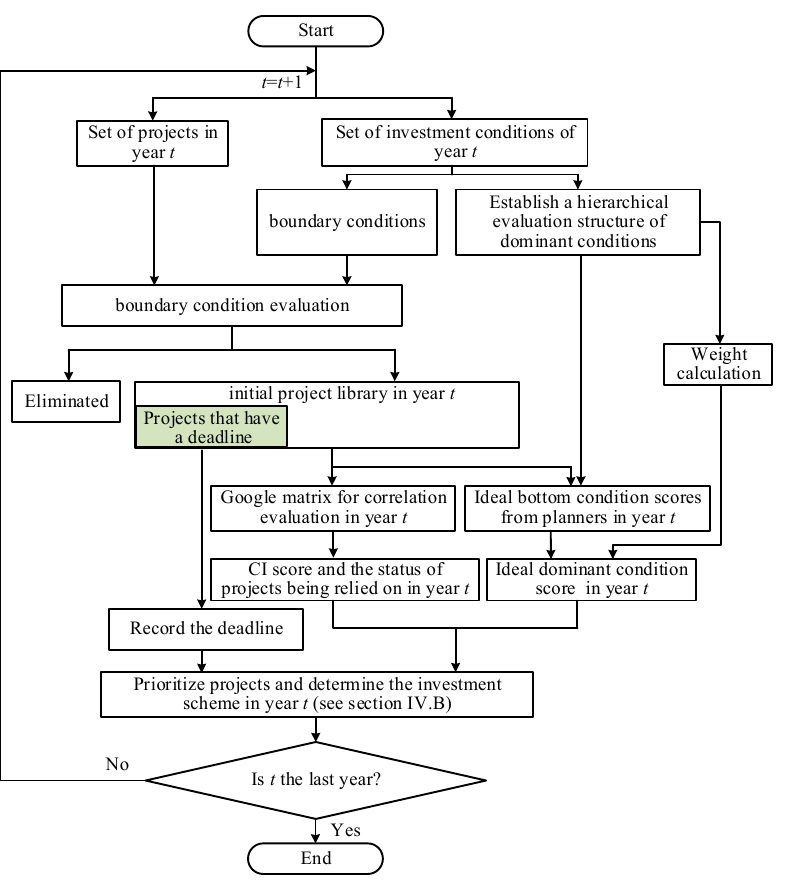
Figure 4. Flow chart of active distribution network rolling optimization planning.